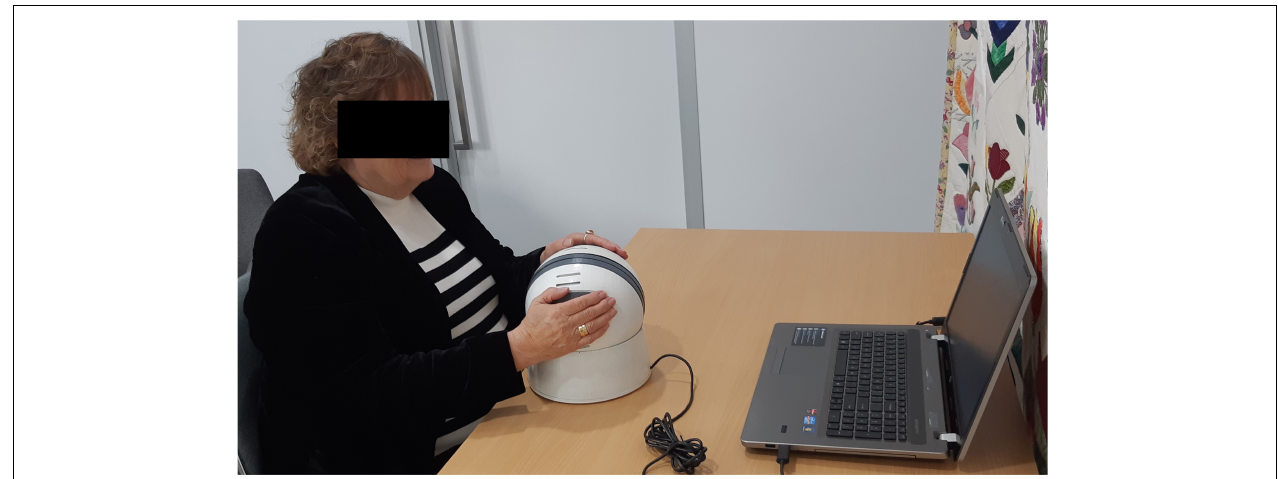
FIGURE 1 | The Orby Controller, which consists of several features specifically adapted for motor dysfunction, including: (1) a spherical shape to allow for ergonomic bimanual control, (2) gray grip pads (partially obscured during use) and optional hand straps to support hand placement, (3) an adjustable sensitivity threshold, to prevent random movements from being interpreted as purposeful, (4) vibration to provide haptic feedback to the player, and (5) a large red selection button on the front of the controller to reduce the fine motor requirement (not